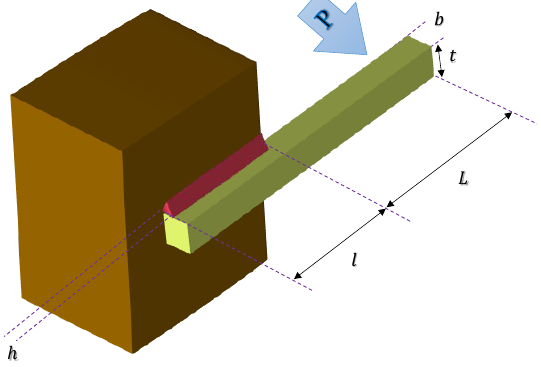
Figure 2. Structure of the WBD problem. Table 1. The value of the estimated parameters using RSRFT and other methods for solving the WBD